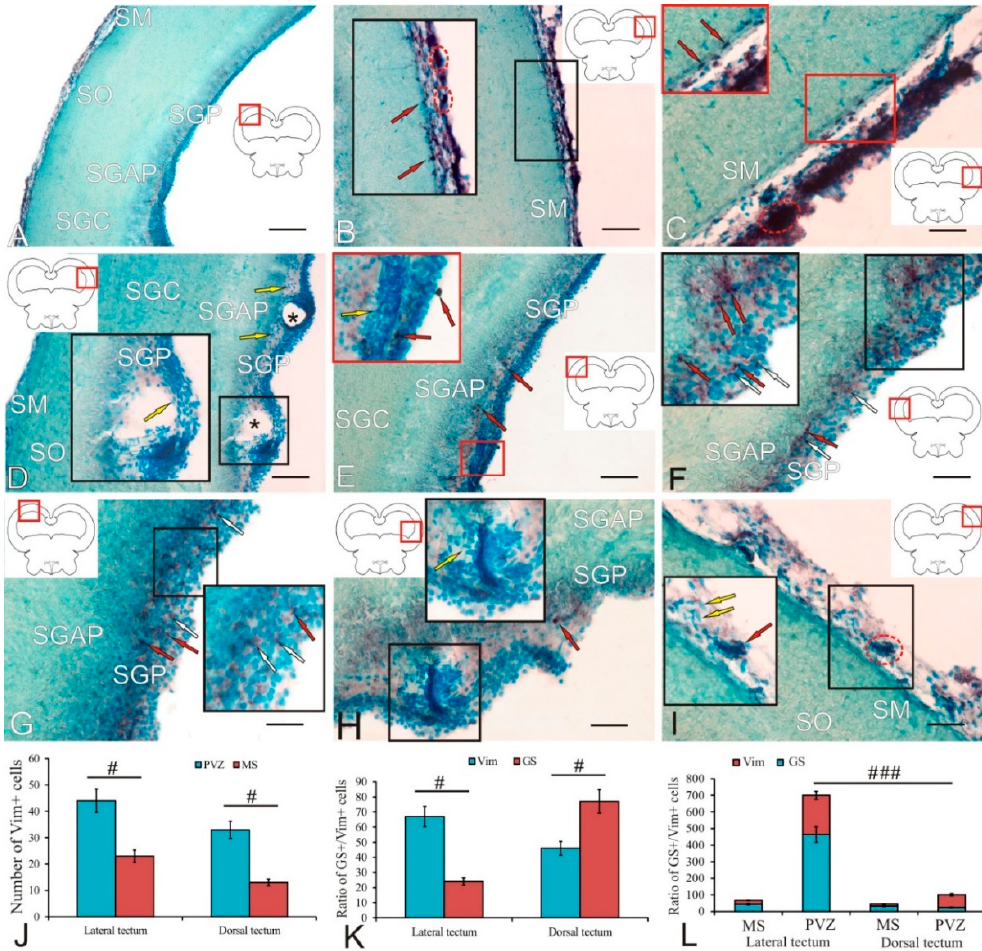
Figure 6. Vimentin (Vim) in the optic tectum of trout, Oncorhynchus mykiss : ( A ) a general view of distribution of vimentin in the tectum; ( B ) Vim+ cells (red arrows) and their clusters (in red dotted oval) in the ependyma and SM (inset) of the lateral tectum; ( C ) elongated intensely or moderately labeled Vim+ migrating cells (inset) in SM; ( D ) immunonegative cavities (asterisks) corresponding to lumens of large vessels (inset) in SGP and elongated Vim − cells (yellow arrows); ( E ) single Vim+ cells (red arrows) in SGP of the dorsolateral tectum (inset), Vim − cells (yellow arrows); ( F ) lateral thickening of SGP (inset) with a diffuse distribution of small intensely labeled Vim+ cells (red arrows) and larger weakly labeled cells (white arrows); ( G ) large moderately (red arrows) or weakly (white arrows) labeled Vim+ SGP cells (inset) of the dorsal tectum; ( H ) single Vim+ NE type cells (red arrow) and complex morphological patterns (inset) of resident and migrating immunonegative cells (yellow arrow) in the lateral proliferative zone of the tectum; ( I ) immunonegative cells (yellow arrows), a dense conglomerate of Vim+ cells (red dotted oval) in the ependyma (inset) of the dorsolateral tectum, and Vim+ cells (red arrow). Scale bars: ( A ) 200 µ m, ( B , D , E ) 100 µ m, and ( C , F – I ) 50 µ m. ( J ) A comparative distribution of Vim+ cells in the lateral and dorsal tectum with significant intergroup differences in the number of cells in the PVZ and SM of the lateral and dorsal tectum, # ( p < 0.05) ( n = 5 in each group), one-way ANOVA; ( K ) a comparative distribution of Vim+ and GS+ cells in the lateral and dorsal tectum with significant intergroup differences in the number of cells in the PVZ and SM of the lateral and dorsal tectum, # ( p < 0.05) ( n = 5 in each group), one-way ANOVA; ( L ) a comparative distribution of Vim+ and GS+ cells in the lateral and dorsal tectum with significant intergroup differences in the number of cells in the PVZ of the lateral and dorsal tectum, ### ( p < 0.001) ( n = 5 in each group), one-way